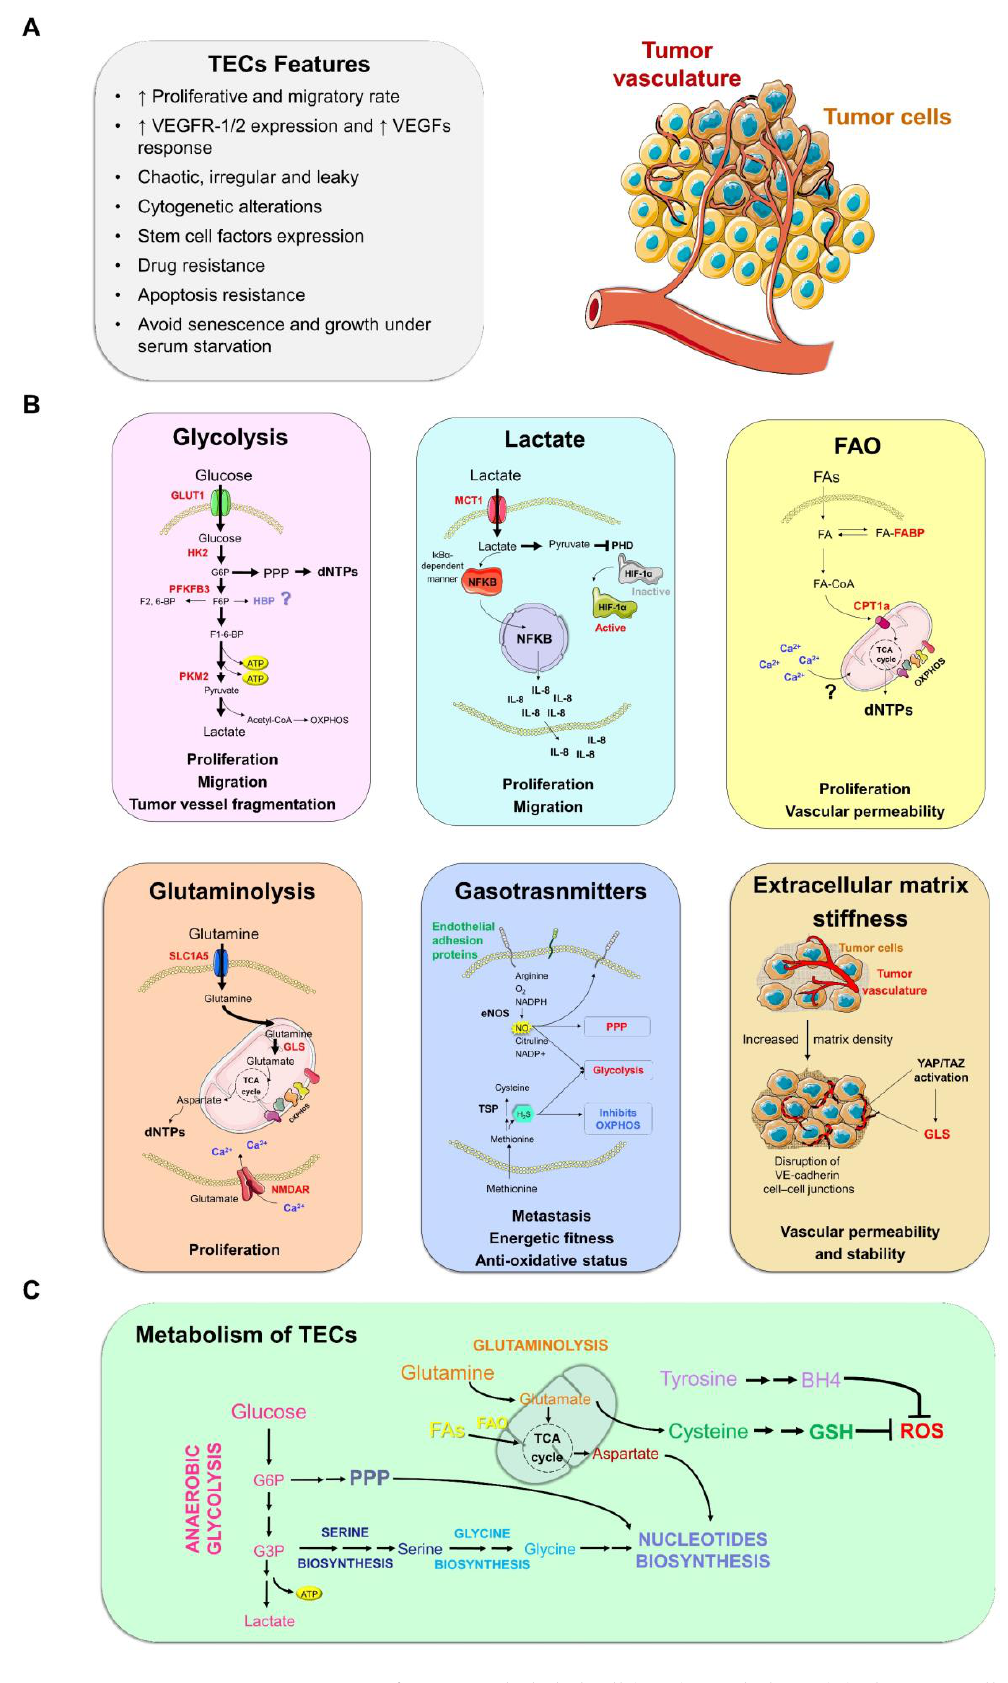
Figure 1. Overview of tumor endothelial cell (TEC) metabolism. ( A ) Phenotypically, TECs show